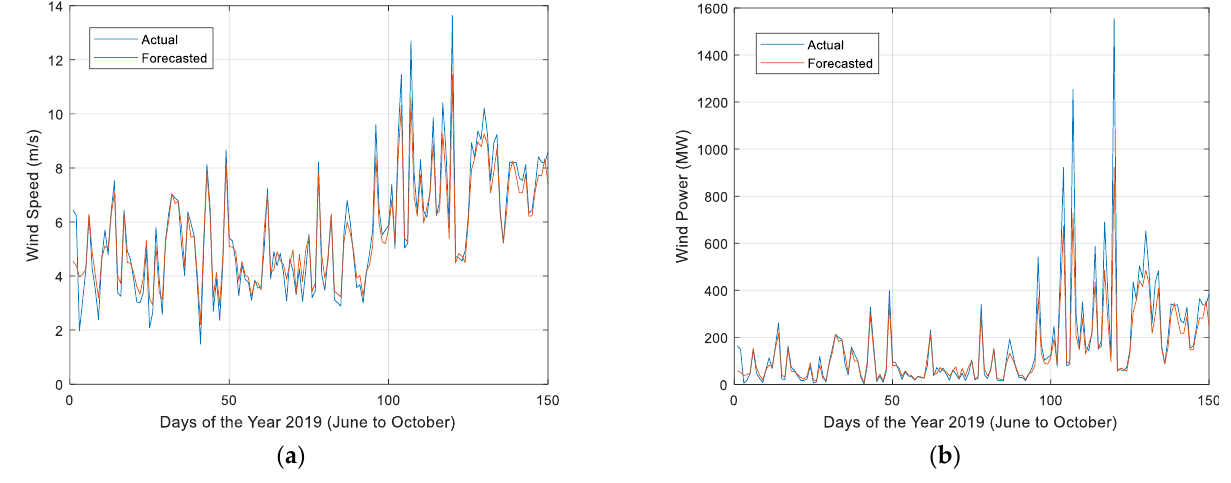
Figure 11. ( a ) Comparative analysis of wind speed forecasting by the FFNN trained through MHPSO-BAAC- χ. ( b ) Comparative analysis of wind power forecasting by the FFNN trained through MHPSO-BAAC- χ.